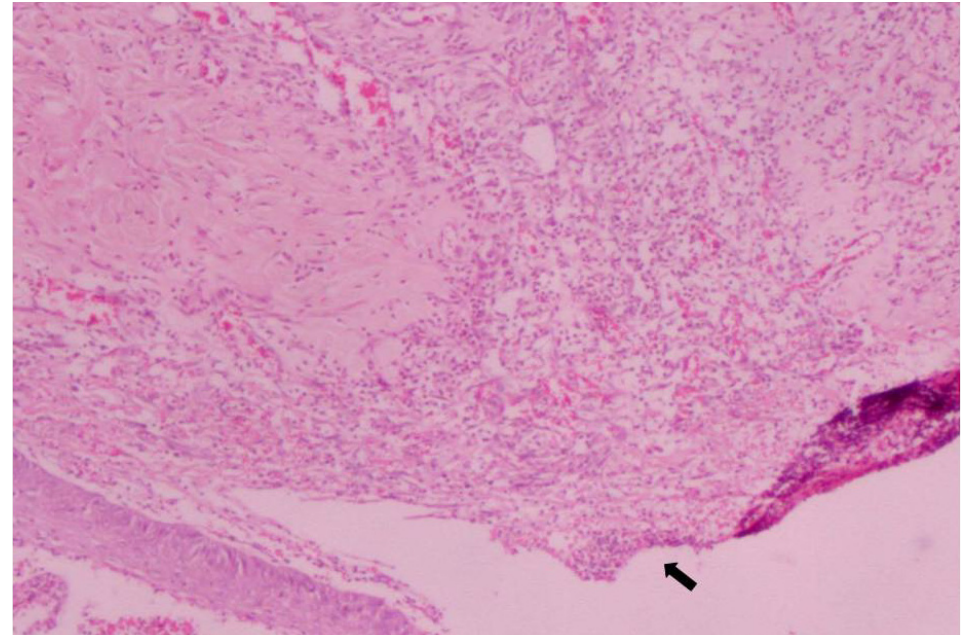
FIGURE 2 - Incomplete epithelialization (black arrow) in enoxaparin treated group (HE, 40x)